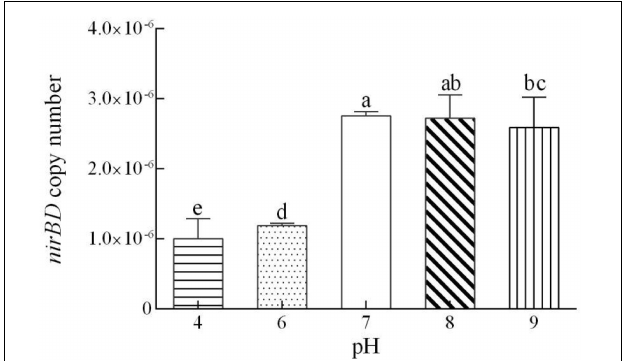
FIGURE 6 | Quantitative measurement of the nirBD expression in Pseudomonas putida Y-9 cultured in different initial pH mediums (with glucose as the sole carbon source) for 4 d. The values are expressed as the number of copies/10 10 copies of 16S rRNA. The different lowercase letters above the bars indicate significant differences among treatments ( P < 0.05).